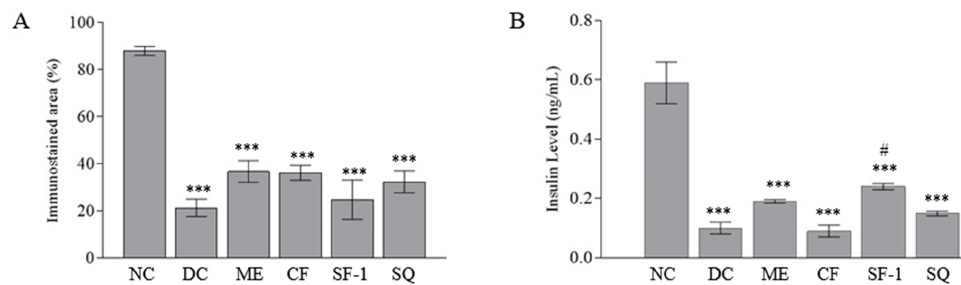
Figure 6 . Immunohistochemistry staining of the β -cells pancreas after being treated for 12 days.